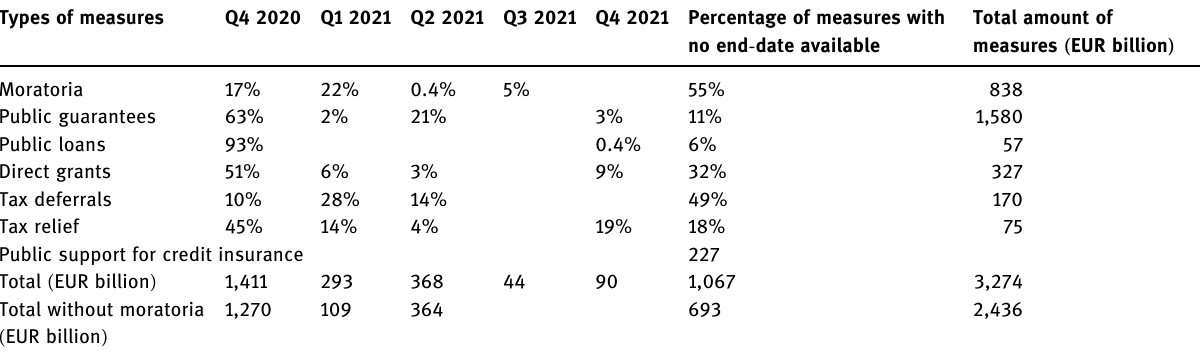
Table 2: Amounts of fi scal - budgetary measures provided for period Q4 2020 – Q4 2021, September 2020 Types of